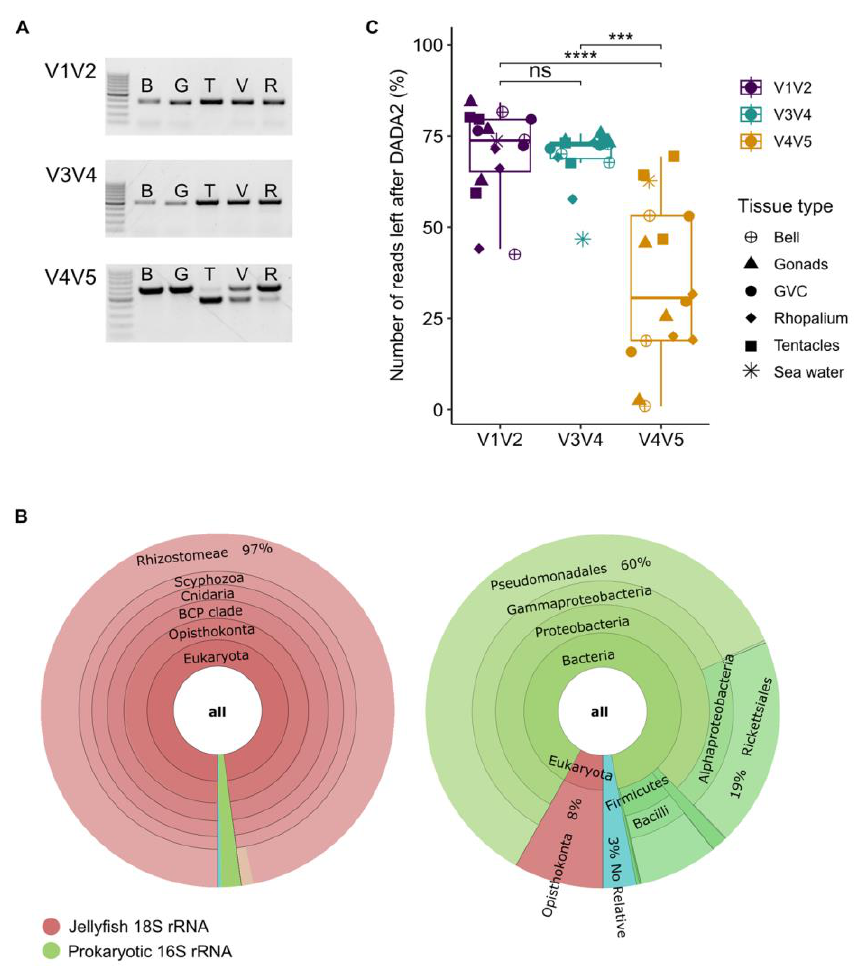
Figure 2. The double-band effect on downstream analysis. ( A ) PCR amplicons products for five jellyfish tissues, and three primer sets. B—bell, G—gonads, T—tentacles, V—gastrovascular canals, and R—rhoplium. ( B ) Percentage of initial reads remaining after DADA2 processing. The V4V5 remaining reads were significantly less than the other two primer sets (Kruskal–Wallis and Dunn’s tests. p < 0.001). ( C ) Visualization of relative abundance sequences in high vs. low bands obtained with V4V5 primers with the Krona RSF display tool [46]. *** and **** indicate p- value < 0.001 or 0.0001 level, respectively, while “ns” indicate non-significant results.